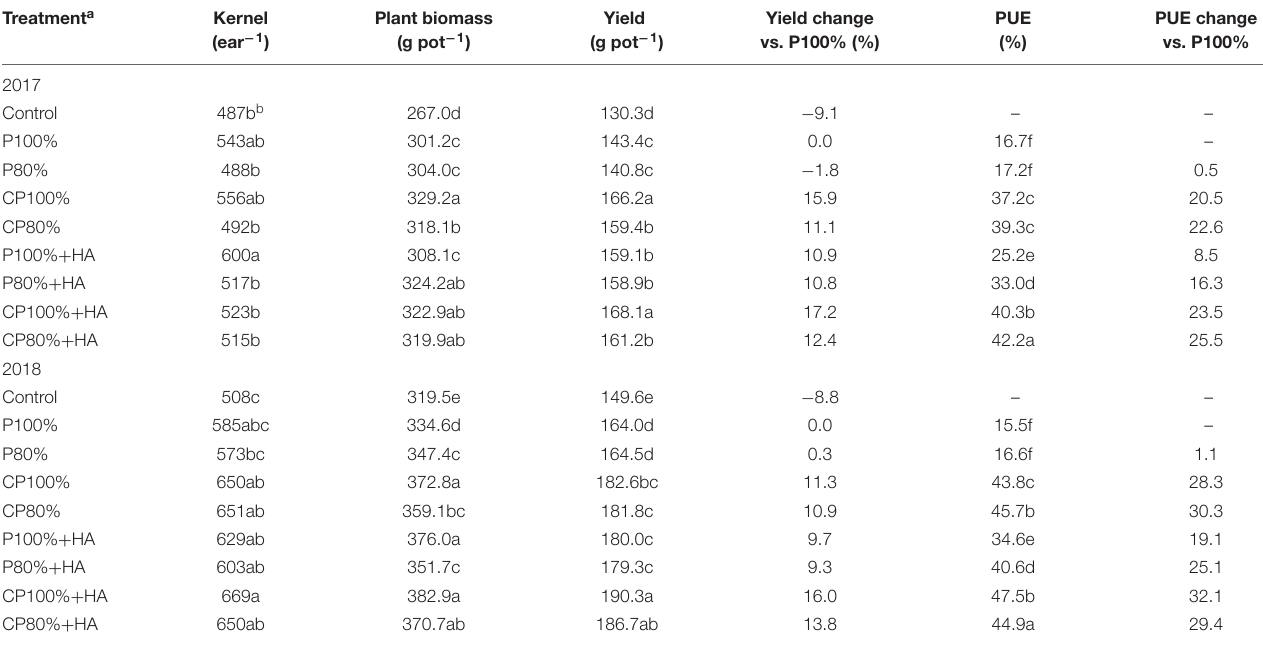
TABLE 2 | Maize yield and phosphorus use efficiency (PUE) in different fertilization treatments. Treatment